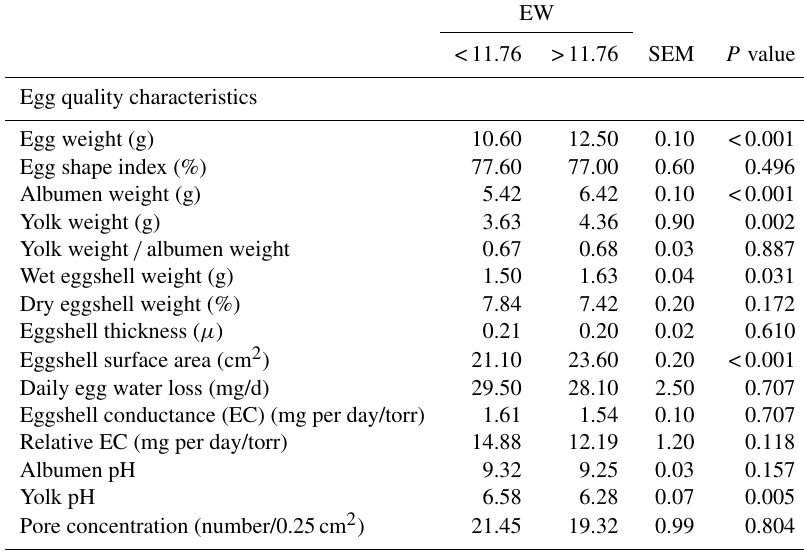
Table 1. The effect of egg weight on egg quality characteristics prior to incubation of hatching eggs in the breeder quail.